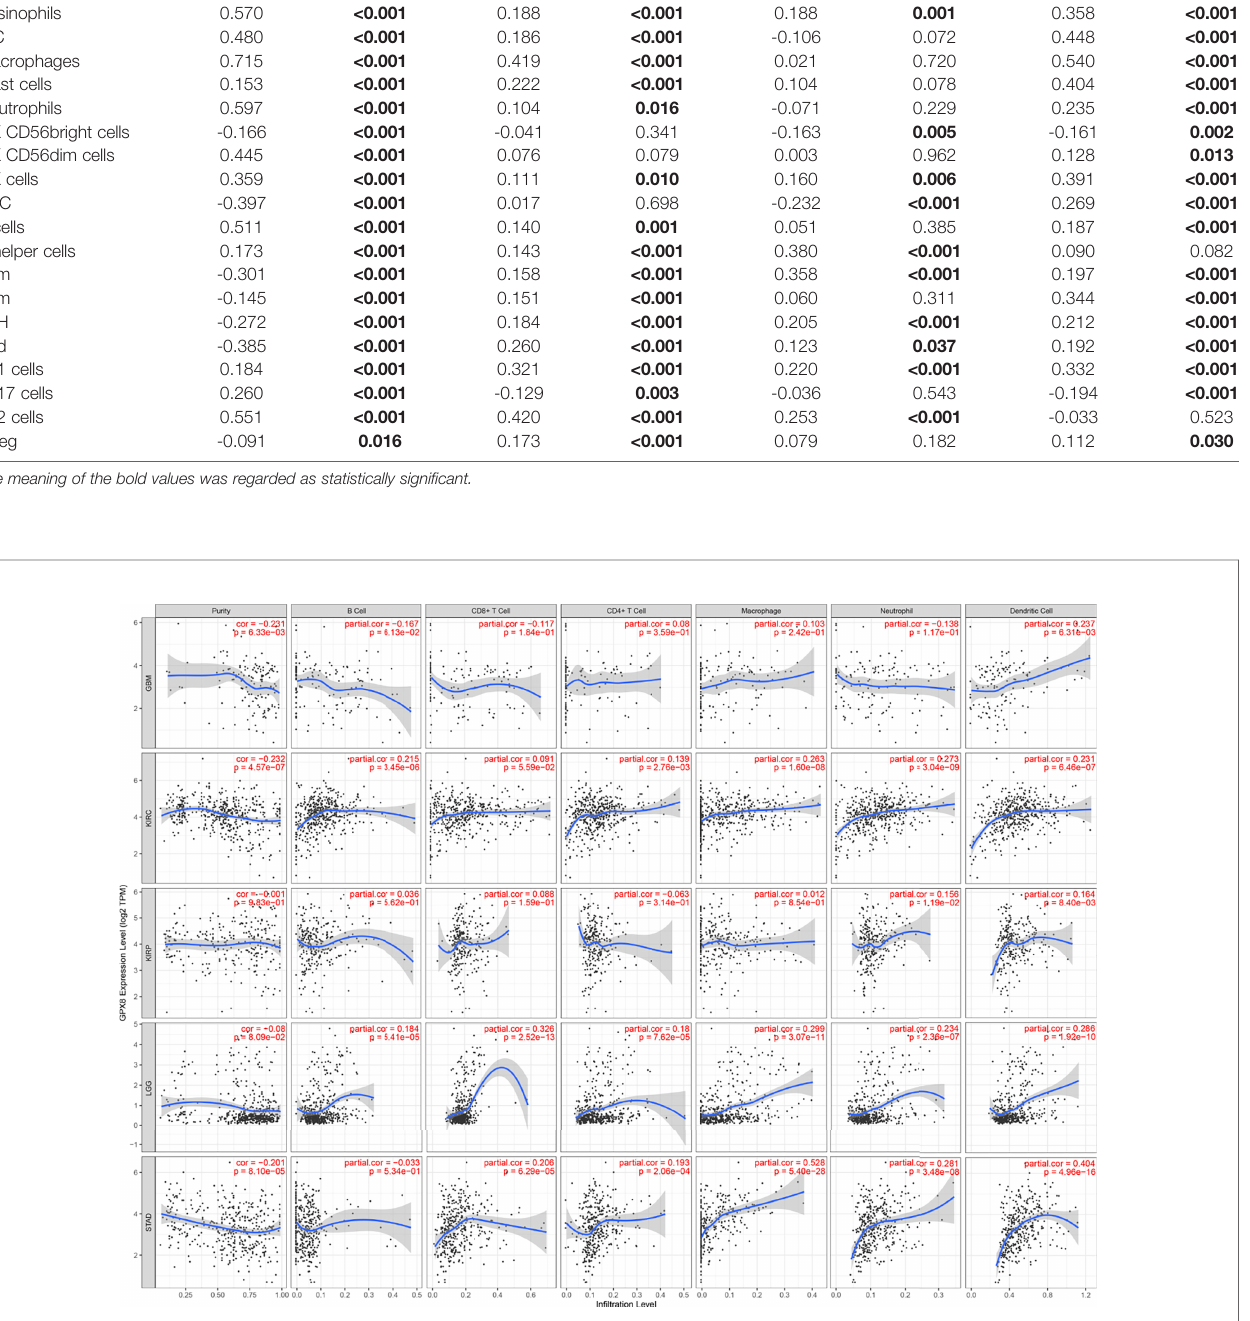
FIGURE 6 | Correlation analysis between GPX8 expression and immune cells in TIMER